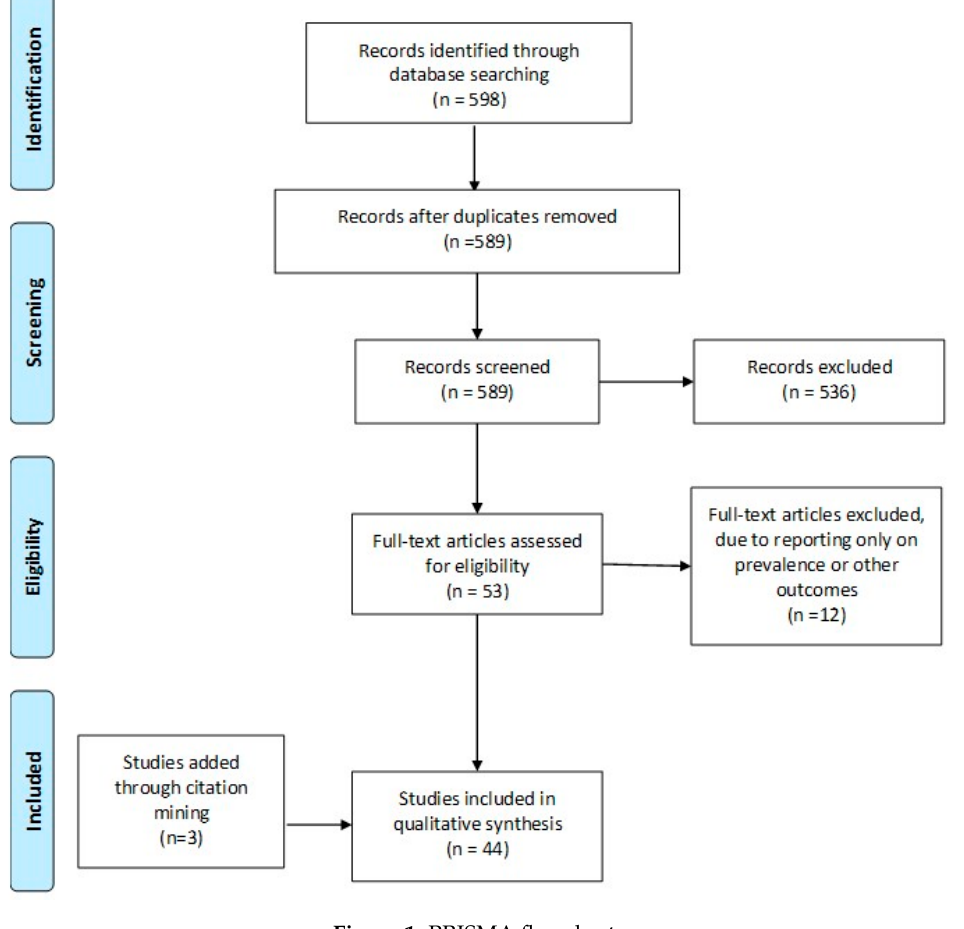
Figure 1. PRISMA Figure 1. PRISMA flowchart.